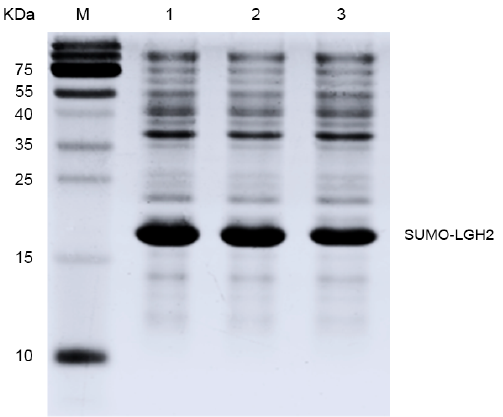
Figure 3. The expression of fusion protein SUMO-LGH2 from E. coli (DE3) plysS. Lane M contains the molecular mass marker; Lanes 1–3 are the protein expression of three monoclonal colons.